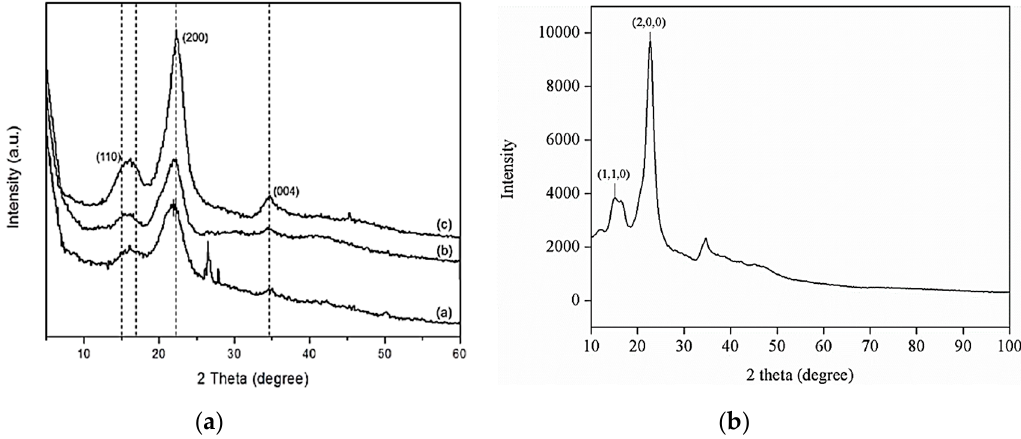
Figure 7. Comparison of the XRD patterns of the CNC nanoparticles from ( a ) Kumar, Negi [55] and ( b ) the current study. Figure 7a is reproduced with permission from [Kumar, A.; Negi, Y.S.; Choudhary, V.; Bhardwaj, N.K. Characterization of cellulose nanocrystals produced by acid ‐ hydrolysis from sugarcane bagasse as agro ‐ waste, Pubslihed by Journal of Materials Physics and Chemistry, 2014].